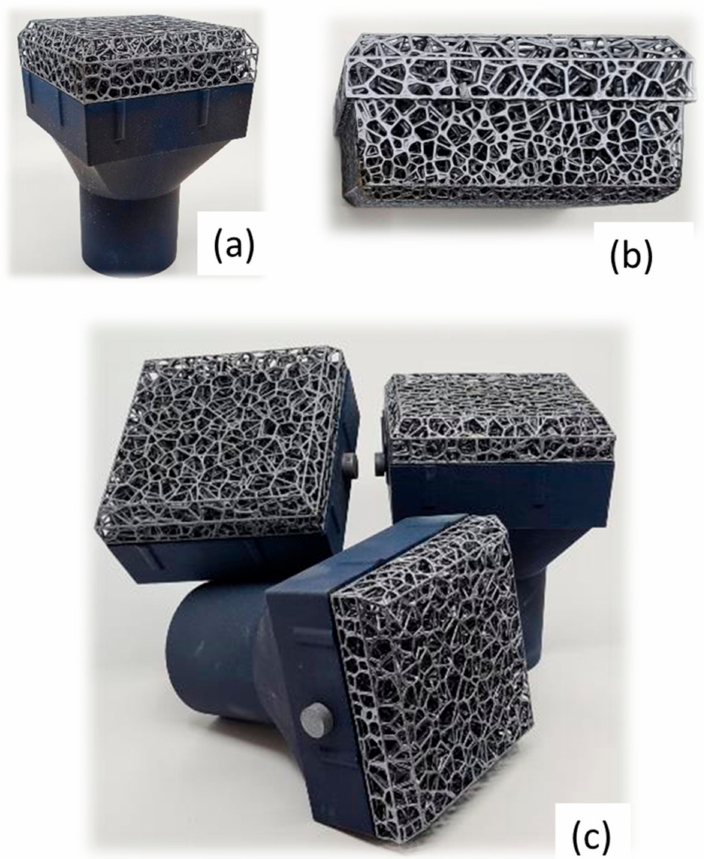
Figure 8. ( a ) SiSiC solar receiver designed and produced by EngiCer; ( b ) macrograph of the SiSiC lattices ( c ) SiSiC-SiC (foam and cup) assembled with the pin.